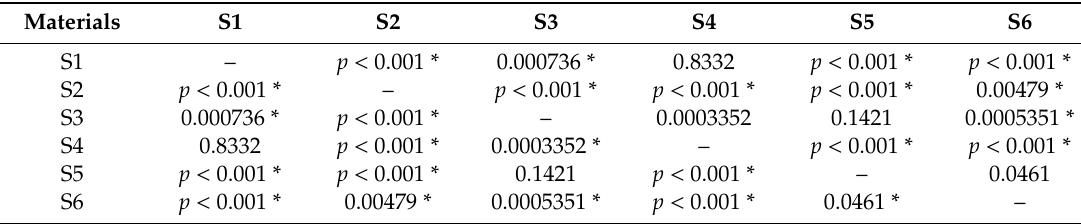
Table 4. Di ff erences in ∆ E after 168 h immersion in co ff ee.